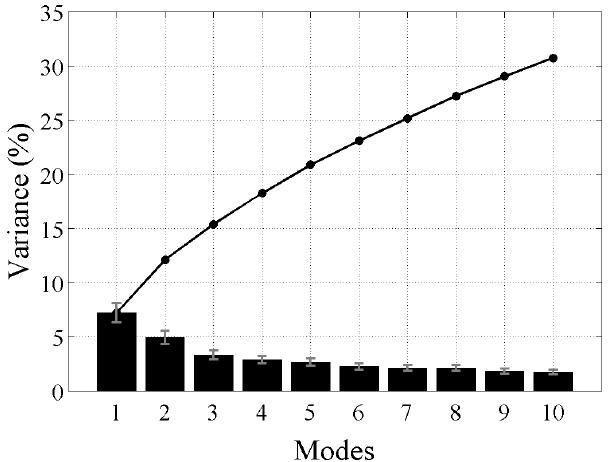
Principal Components (grey) time series and the